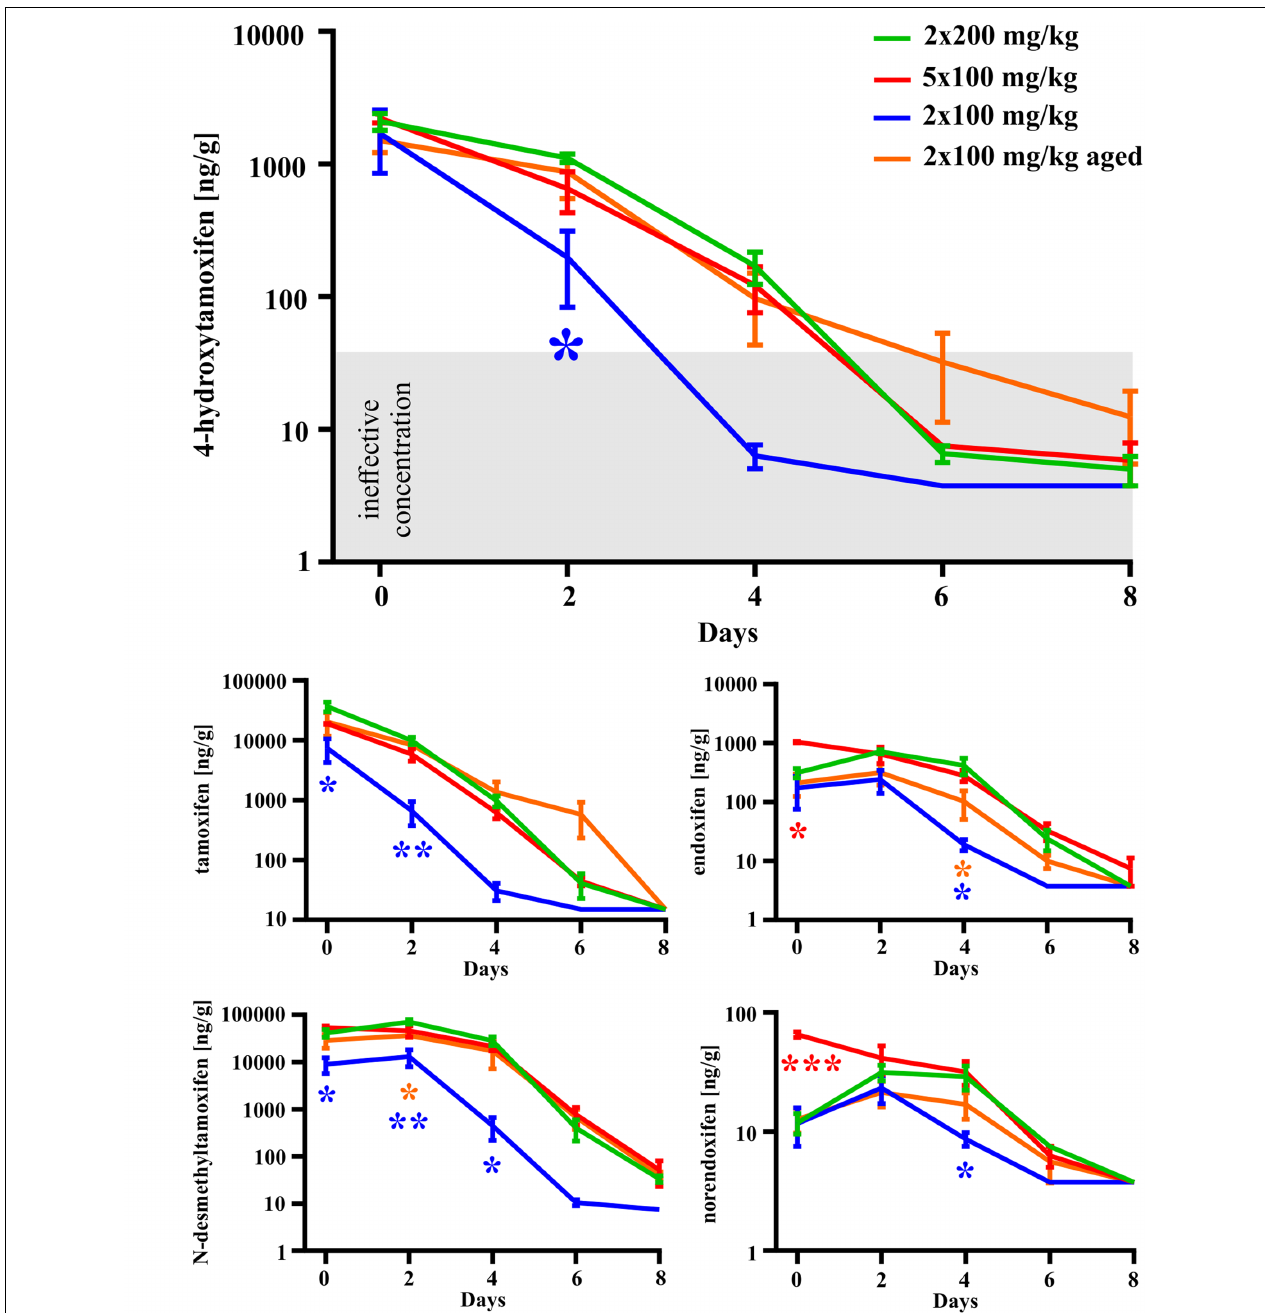
FIGURE 4 | Dose-dependent differences in degradation of tamoxifen and its metabolites in the mouse brains. Degradation of tamoxifen and its metabolites is significantly affected by initial tamoxifen dose. Significances are expressed above the x -axis by an asterisk in the color of the respective group relative to 2 × 200 mg/kg group (green line). Values of p < 0.05 were considered significant ( ∗ ), p < 0.01 very significant ( ∗∗ ) and p < 0.001 extremely significant ( ∗∗∗